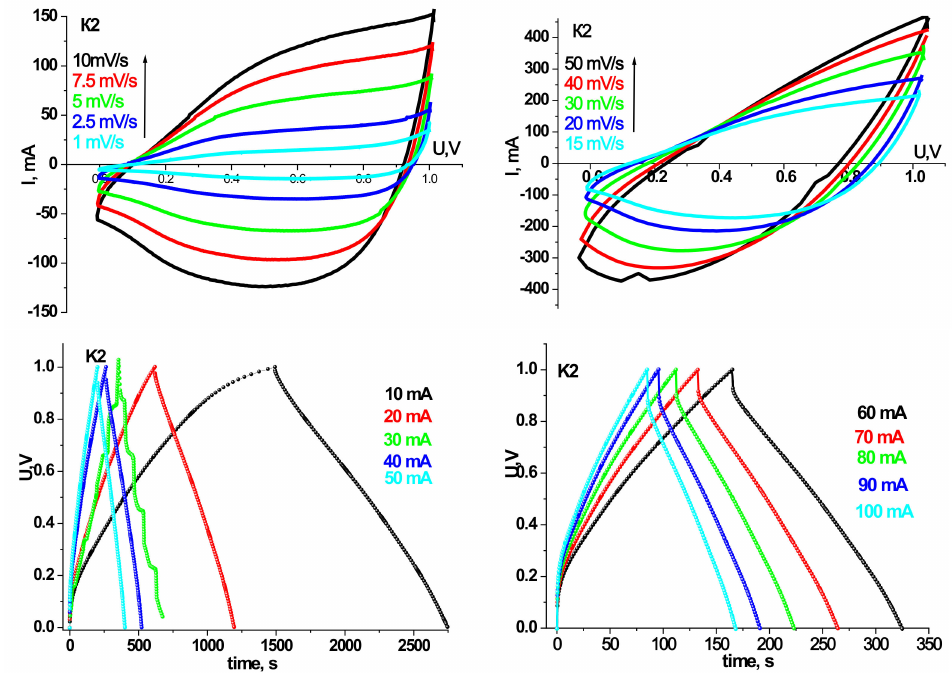
Figure 8. CVA and charge/discharge curves of the layout of HSCs based on the material